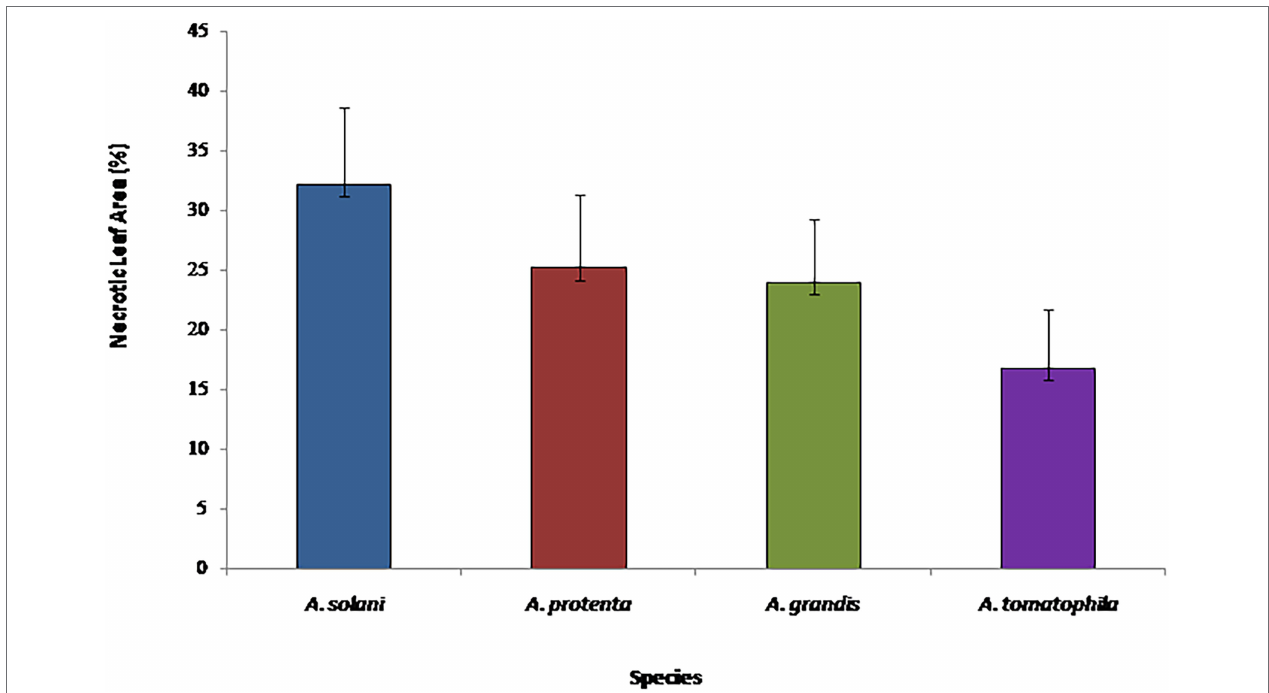
FIGURE 5 | Virulence of Alternaria solani, A. protenta, A. grandis, and A. linariae on potato leaves, under controlled conditions 10 days after inoculation. Multiple- means comparisons were supported by Kruskal–Wallis